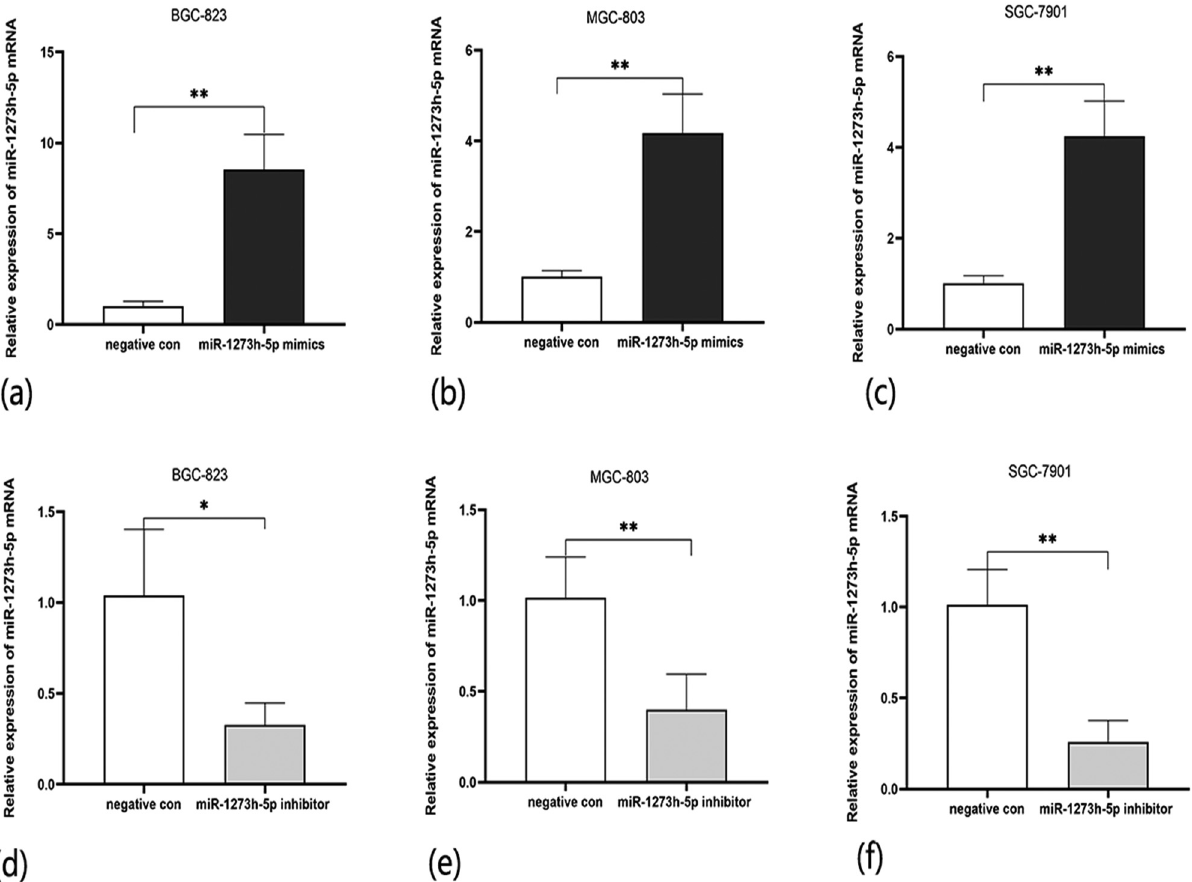
Figure A2: The expression of miR - 1273h - 5p after miR - 1273h - 5p mimics and inhibitor transfection. ( a – c ) The expressions of miR - 1273h - 5p after transplantation of miR - 1273h - 5p mimics into BGC - 823, MGC - 823 and SGC - 7901 cells. ( d – f ) The expressions of miR - 1273h - 5p after transplantation of miR - 1273h - 5p inhibitor into BGC - 823, MGC - 823 and SGC - 7901 cells. All data were represented as M ± SD, * P < 0.05, ** P <